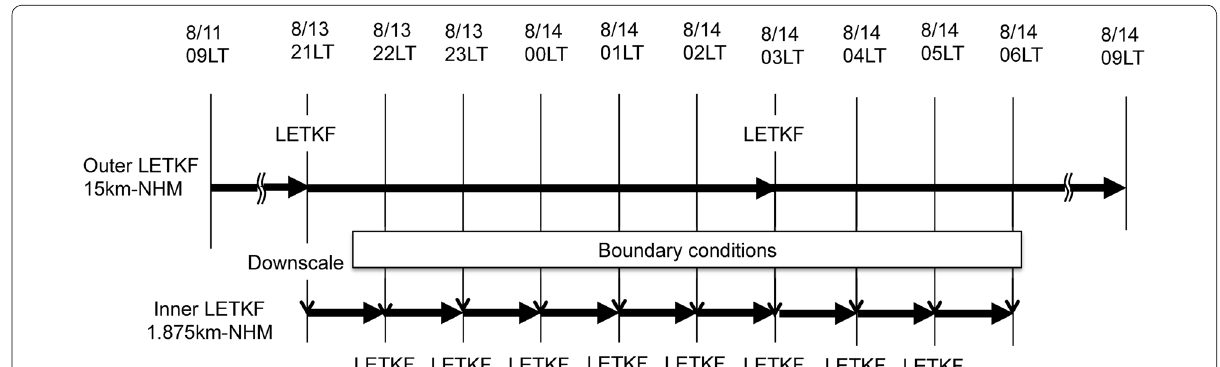
Fig. 6 Flowchart of the data assimilation experiment using the nested NHM-LETKF system. Thick arrows indicate ensemble simulations with 40